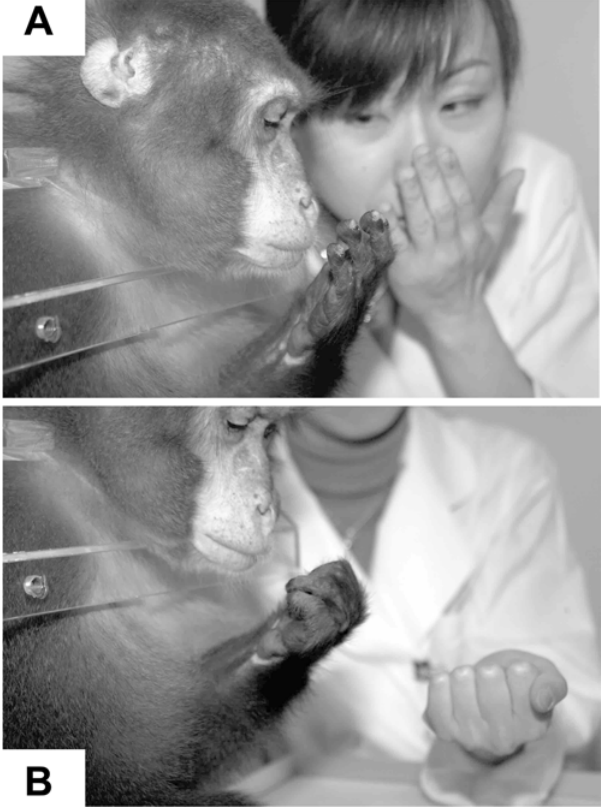
Figure 2. Body-movement imitation. Moving monkey’s hand to touch his face (A). Making his fist